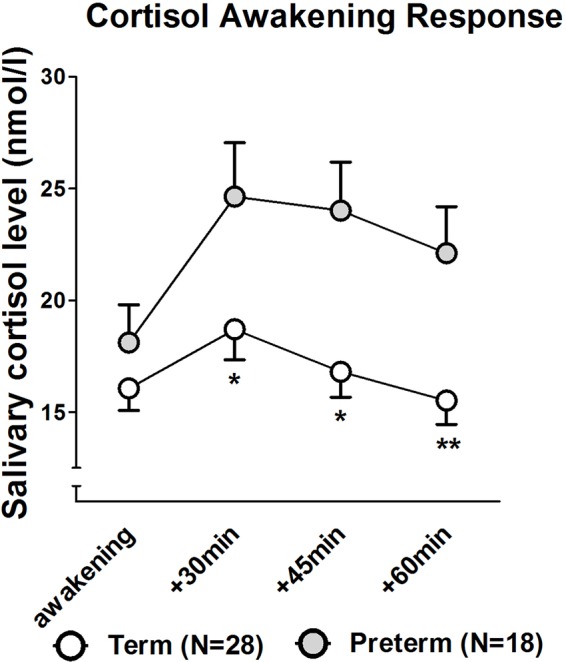
Cortisol awakening response in mothers of infants born at term or preterm. **p < 0.01; *p < 0.05. Data are shown as mean values ± SEM.